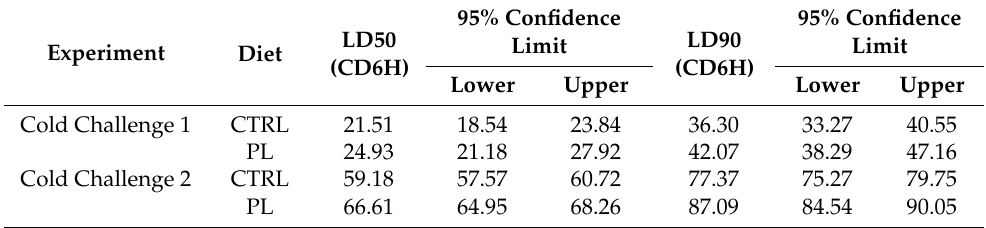
Table 3. Lethal doses (LD50 and LD90) for CD6H data fitted to probit-log(dose) regression models